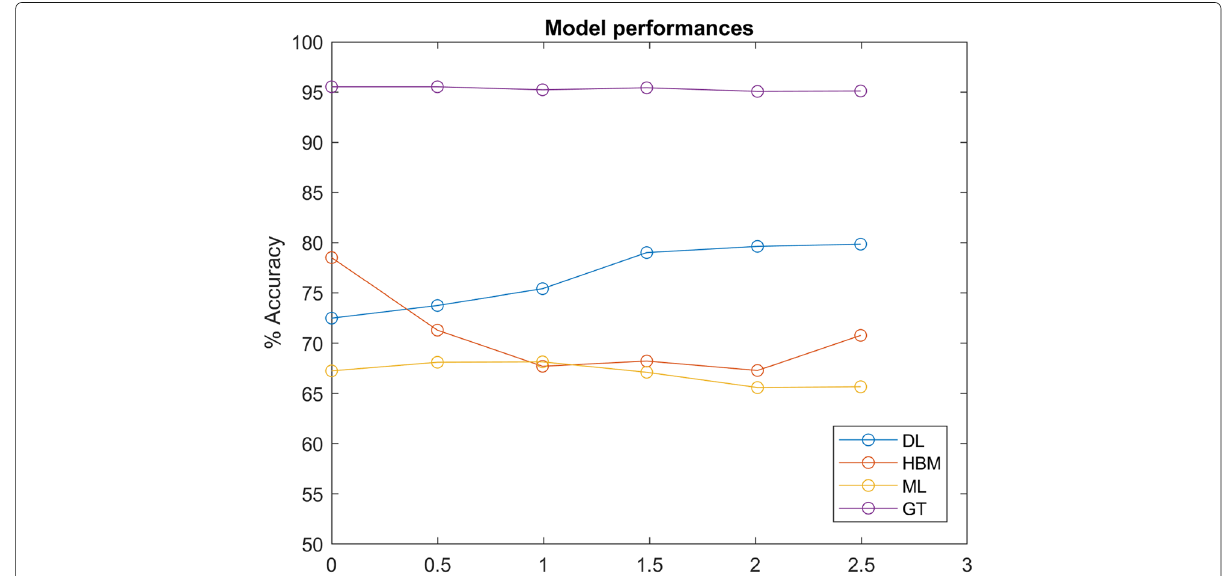
Fig. 15 Model Performances (Generated): Comparison of model performances (DL trained with 2,000 participants involved) over datasets with various underlying distributions of w , denoted by the approximate average of absolute shape factors k ( as applied to the generalized, abstract data. ‘GT’ is the predictive model in which the exact w for each test participant is